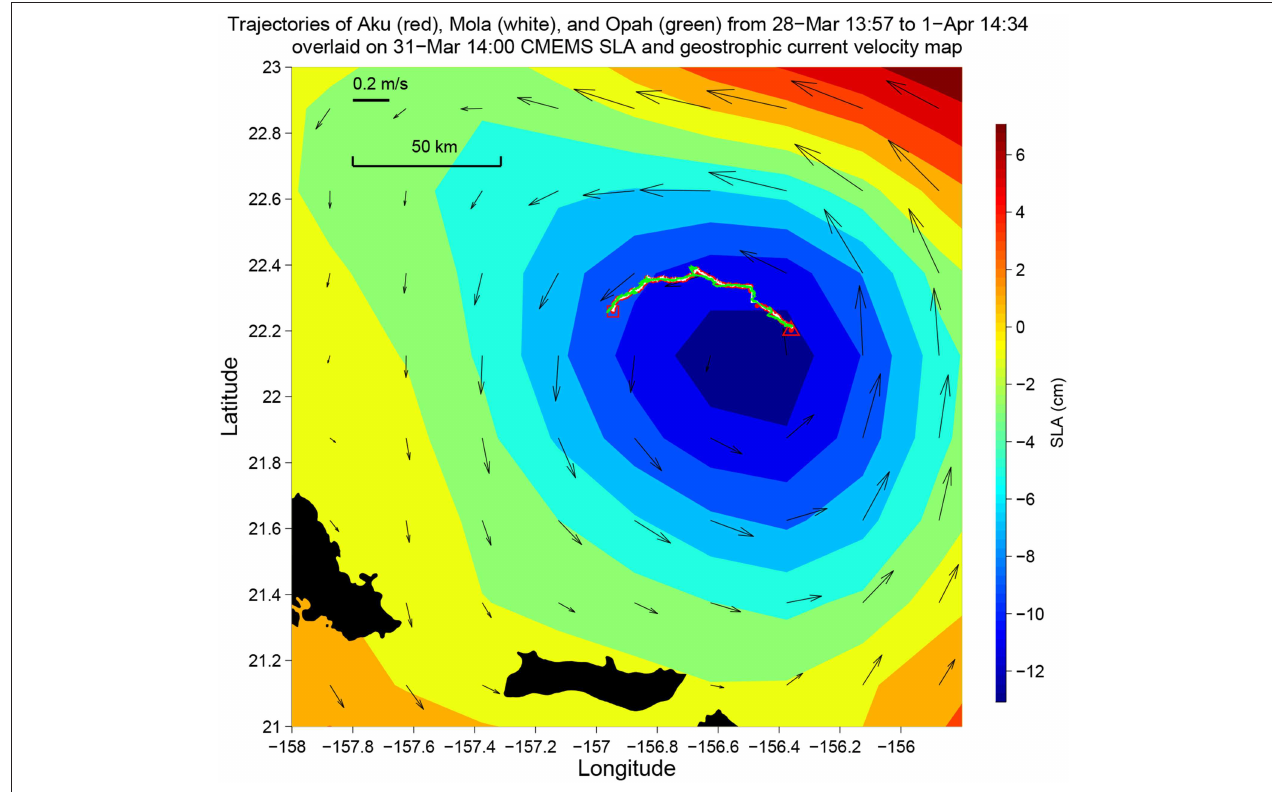
FIGURE 9 | The trajectories of Aku , Opah , and Mola during Aku ’s 4-day sampling mission in the 2018 Hawaiian Eddy Experiment. Their trajectories are overlaid on the Copernicus Marine Environment Monitoring Service (CMEMS) sea level anomaly (SLA) and geostrophic current velocity map. The triangle and the square mark the start and the end of the mission, respectively. Time is in Hawaii Standard Time